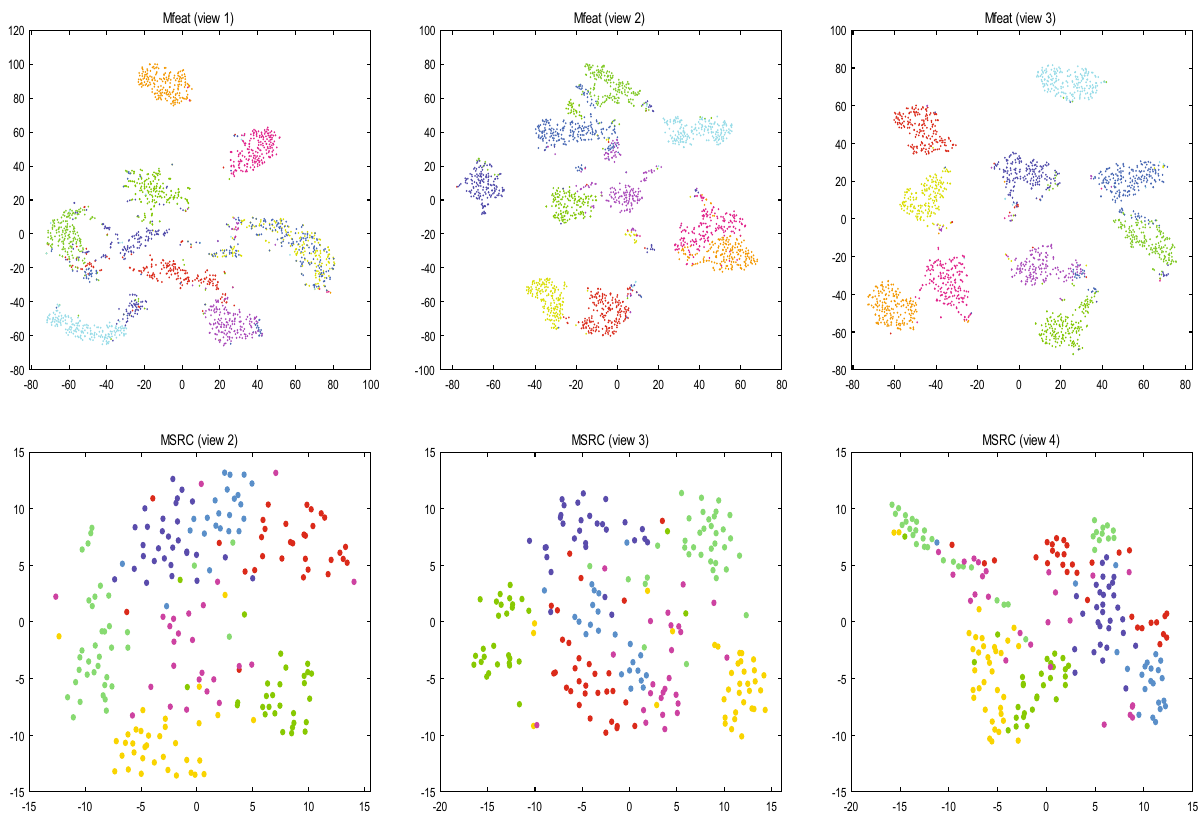
Figure 5. The t-SNE experiments on Mfeat and MSRC